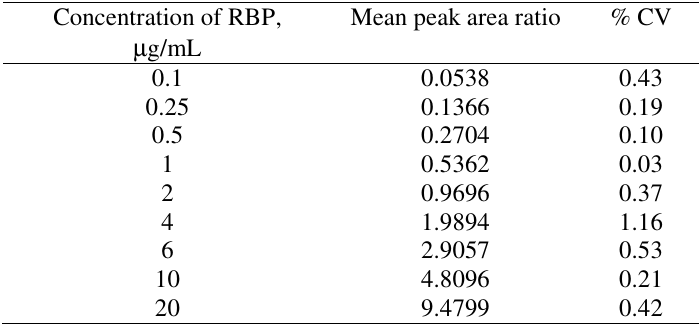
Table 1. Calibration of the proposed HPLC